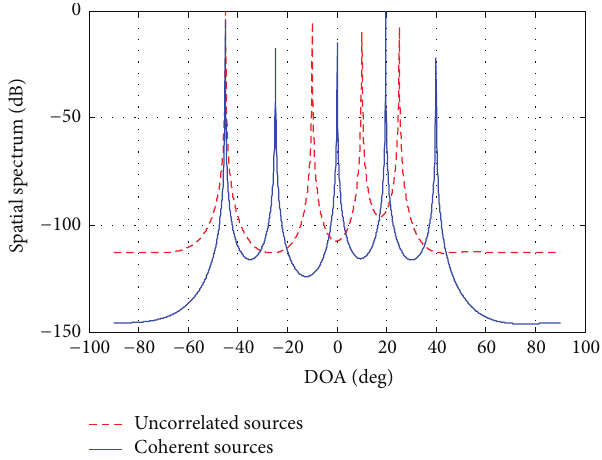
FBSS algorithm (uncorrelated) OP algorithm (uncorrelated) The proposed algorithm (uncorrelated) FBSS algorithm (coherent)